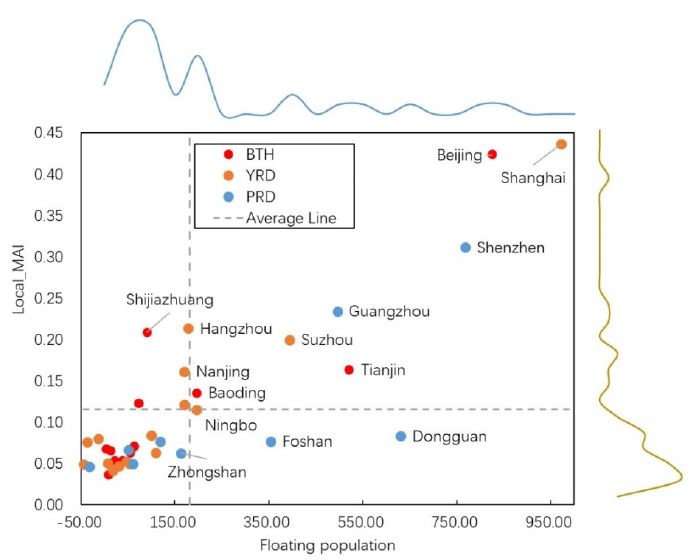
Figure 5. The scatter plot of local-MAI and floating population.